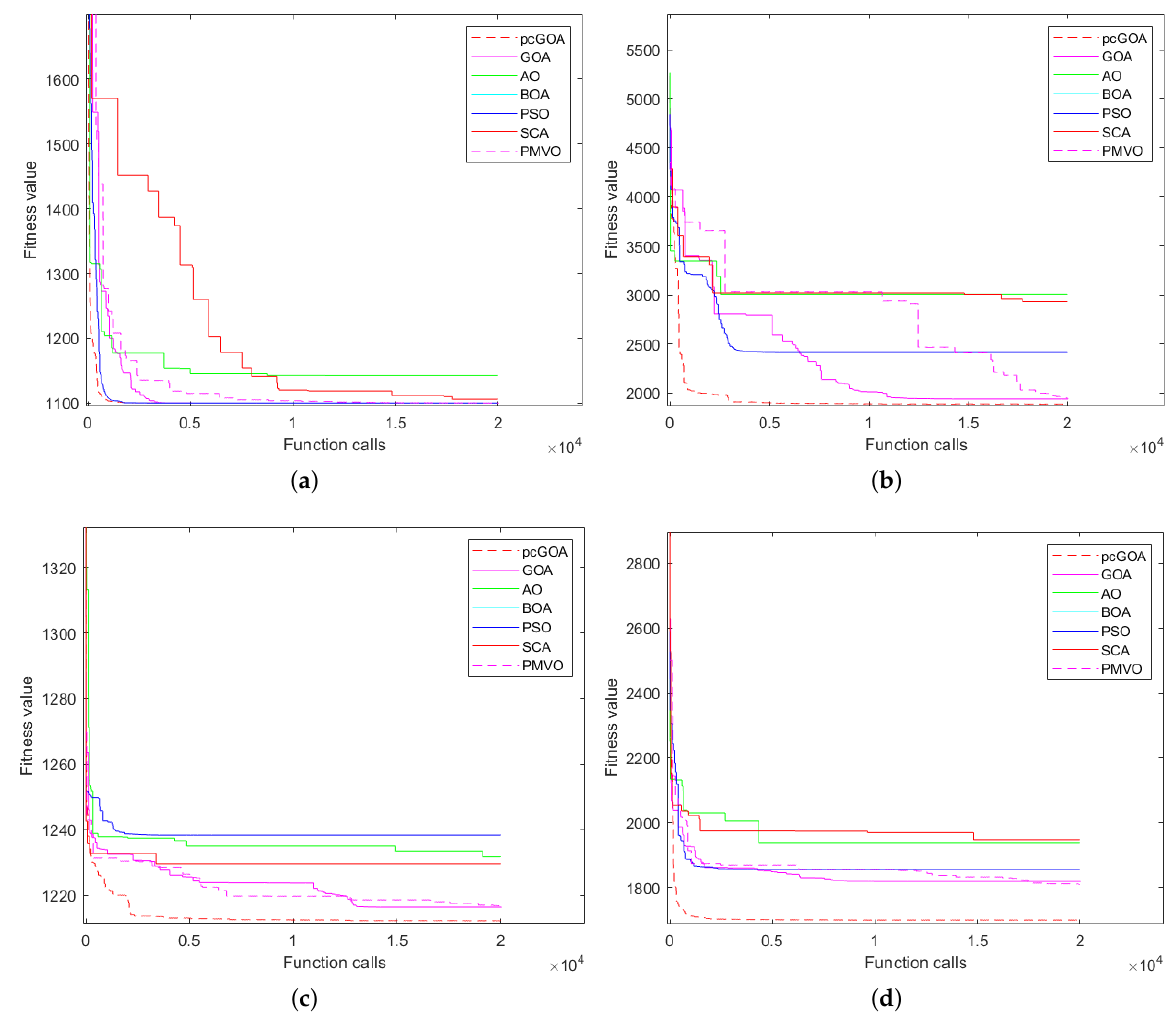
Figure 5. Convergence trend of the composition function of the benchmark function in